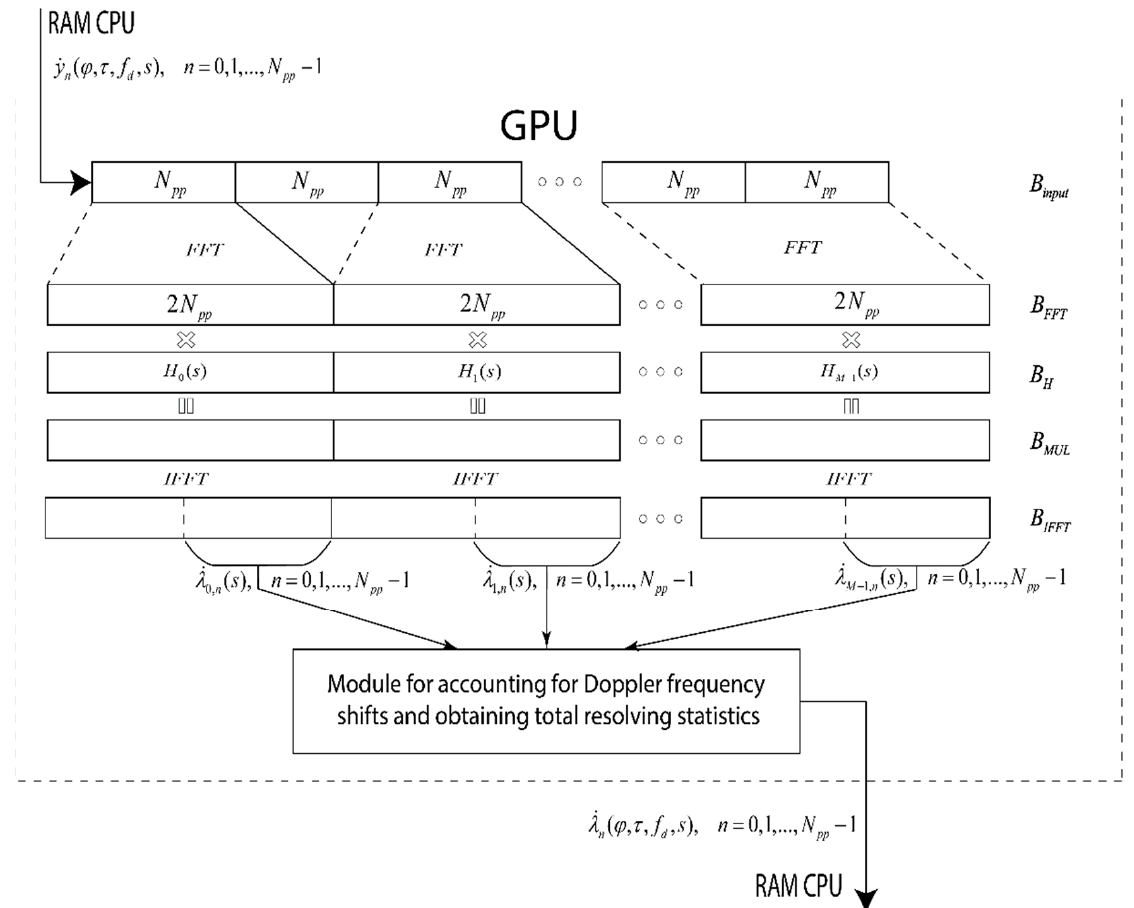
Figure 5. Implementation diagram of a matched filter with a series of sequences.